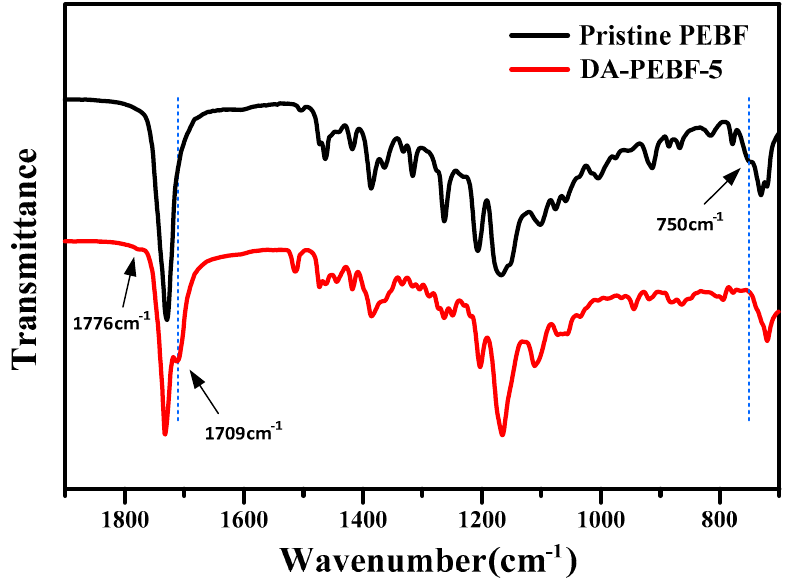
Figure 6. FTIR spectra of pristine PEBF and the DA-PEBF-5 hybrid.